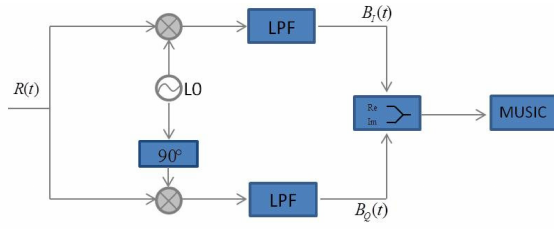
Figure 2: Schematic of the receiving